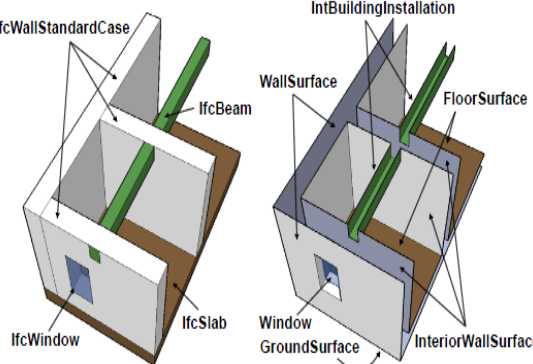
Figure 3. Snapshot of a building storey modeled in IFC (left side) and CityGML (right side) (Nagel et al., 2009).